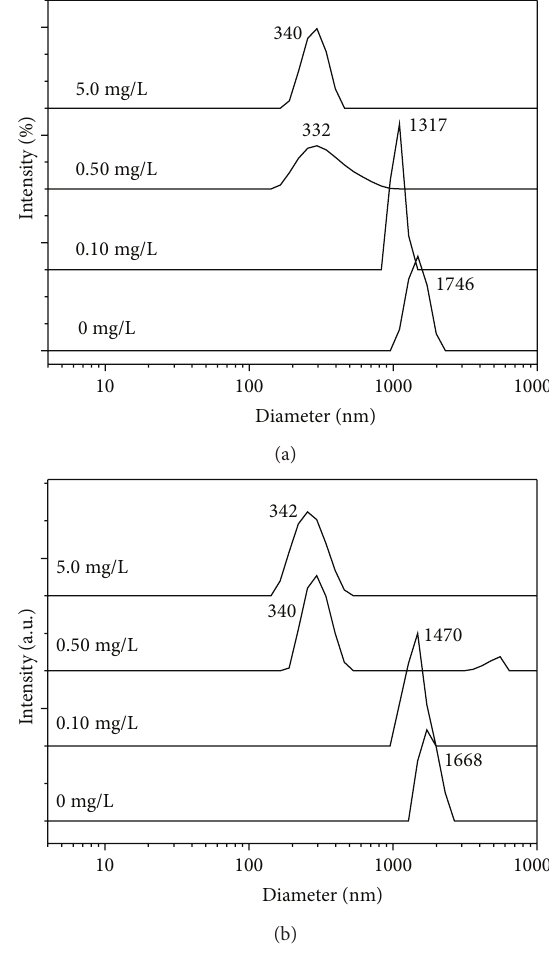
Figure 7: Effect of C 6 S concentration on size distribution of submicron COM and COD crystallites. (a) COM; (b) COD. 𝑡 = 0